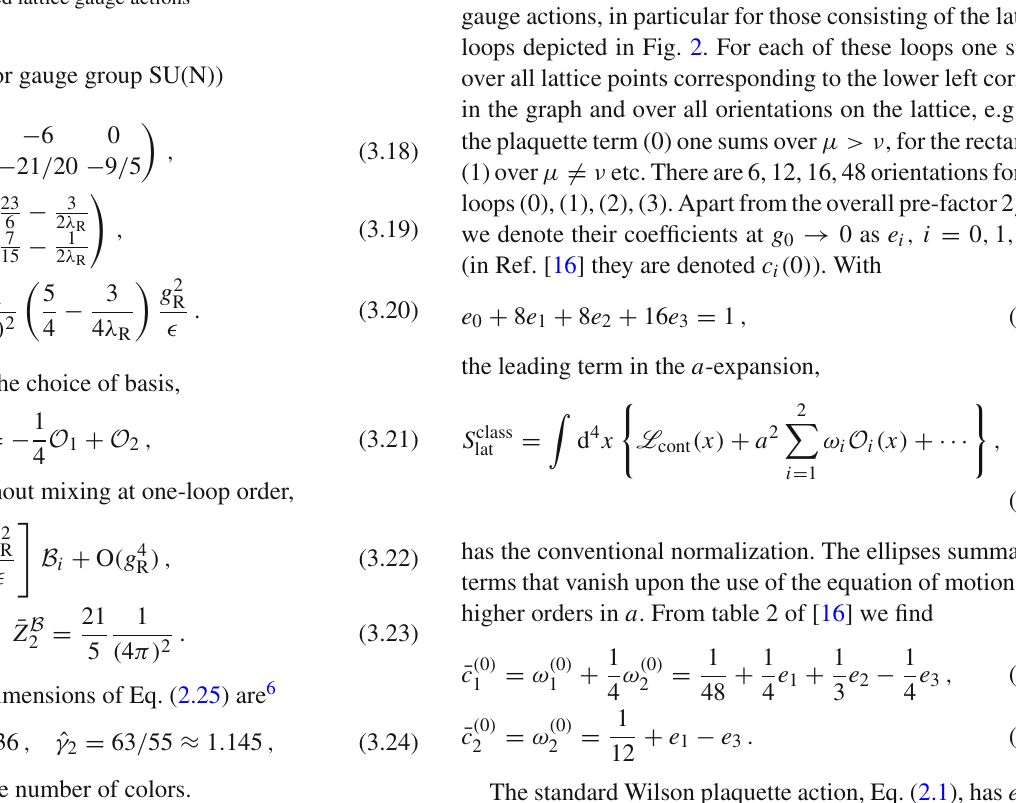
Fig. 2 Graphical representations [5] of the loop geometries contribut- ing to commonly used lattice gauge actions